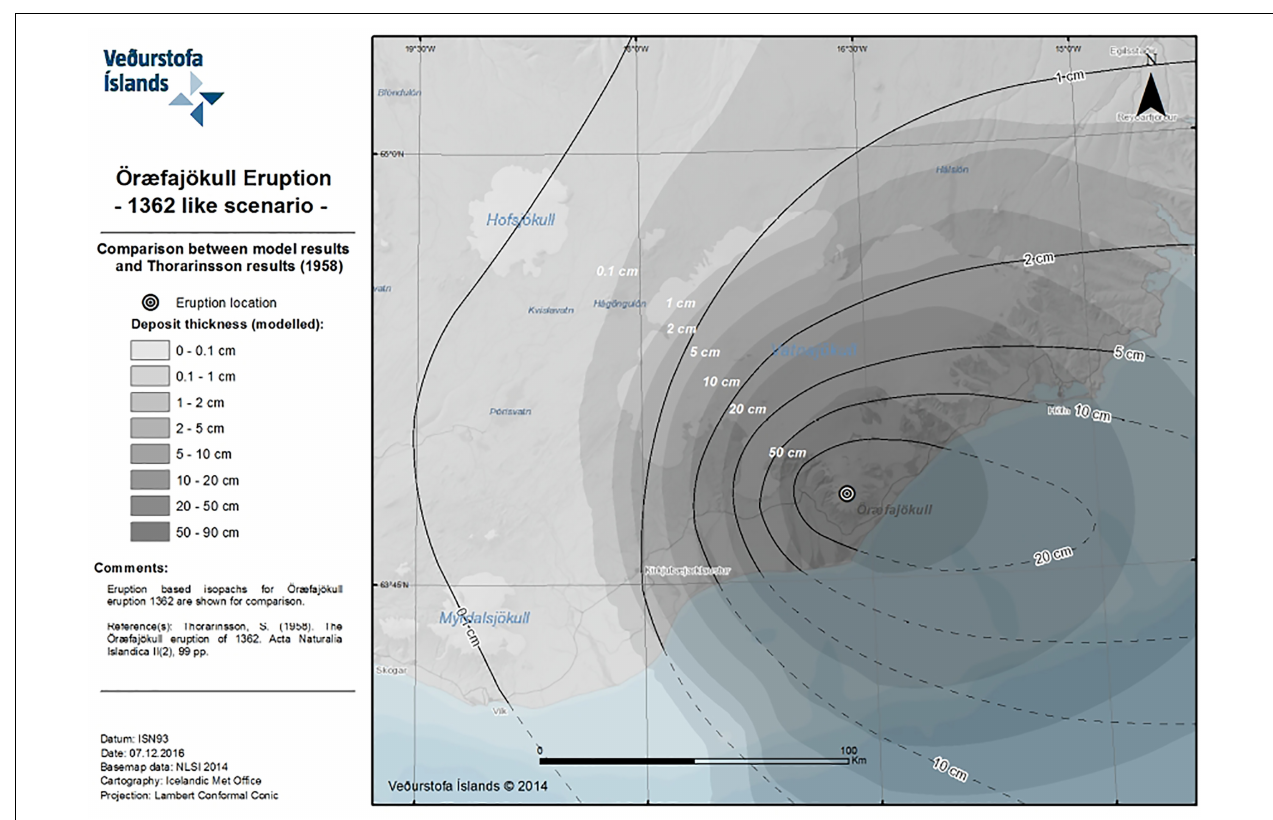
FIGURE 4 | Model results are overlayed with the deposit isopach for the 1362 eruption. The simulation has been run by using a wind field characterized by a westerly wind to match the prevailing direction of the deposit.